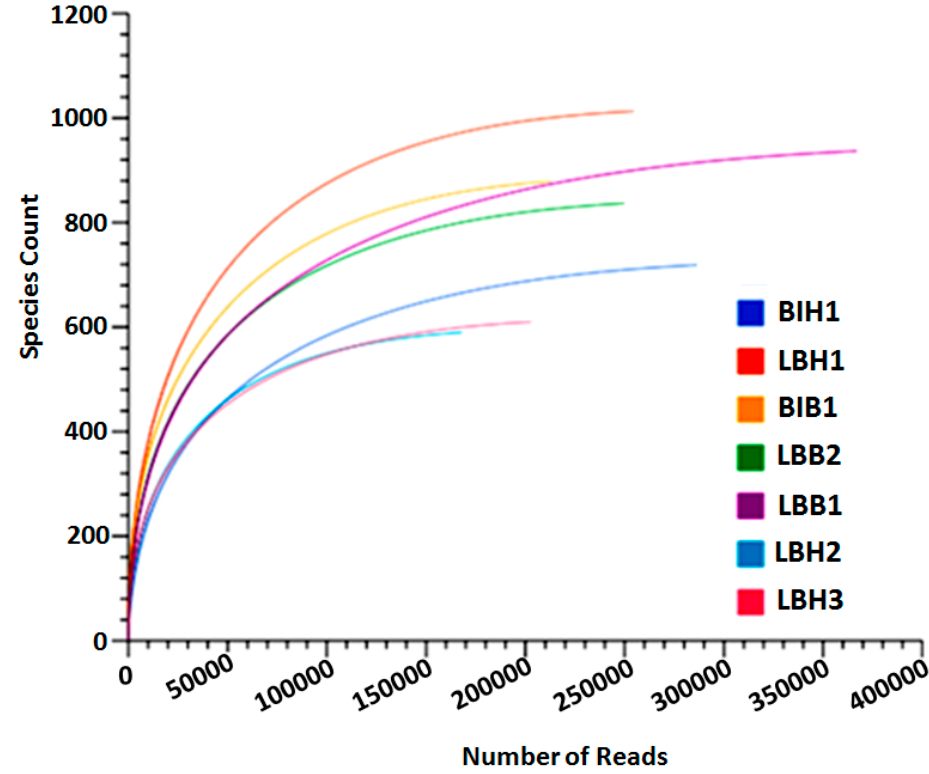
Figure 2. A phylum based rare-fraction curve was predicted among healthy and bleached fresh-water sponges Lubomirskia baikalensis and Baikalospongia intermedia .